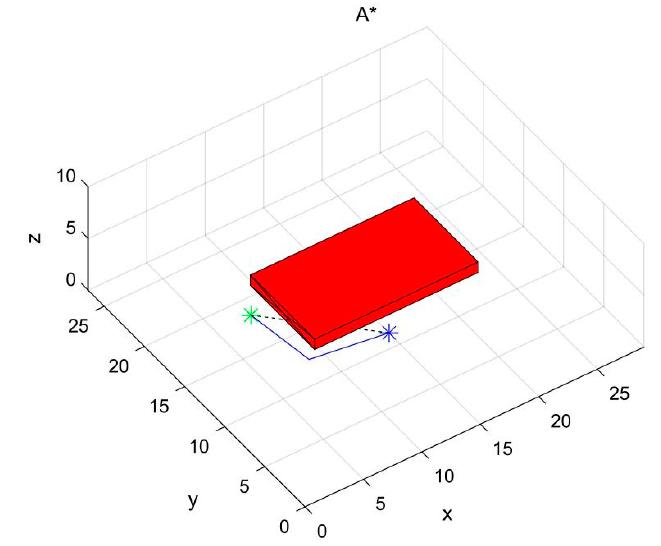
Figure 2. The effect of the A* algorithm in the case of human misjudgments. Figure 2. The e ff ect of the A* algorithm in the case of human